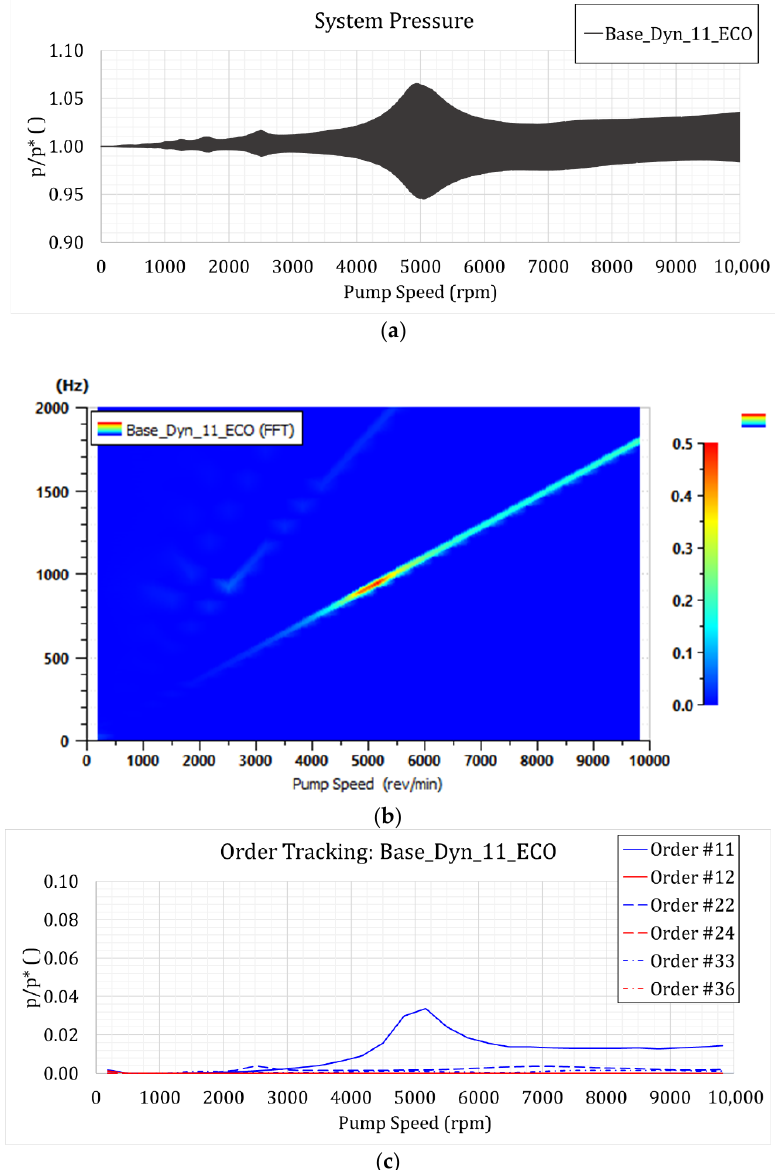
Figure 16. Base_Dyn_11_ECO ’s results: ( a ) system pressure; ( b ) spectral map; ( c ) order tracking.